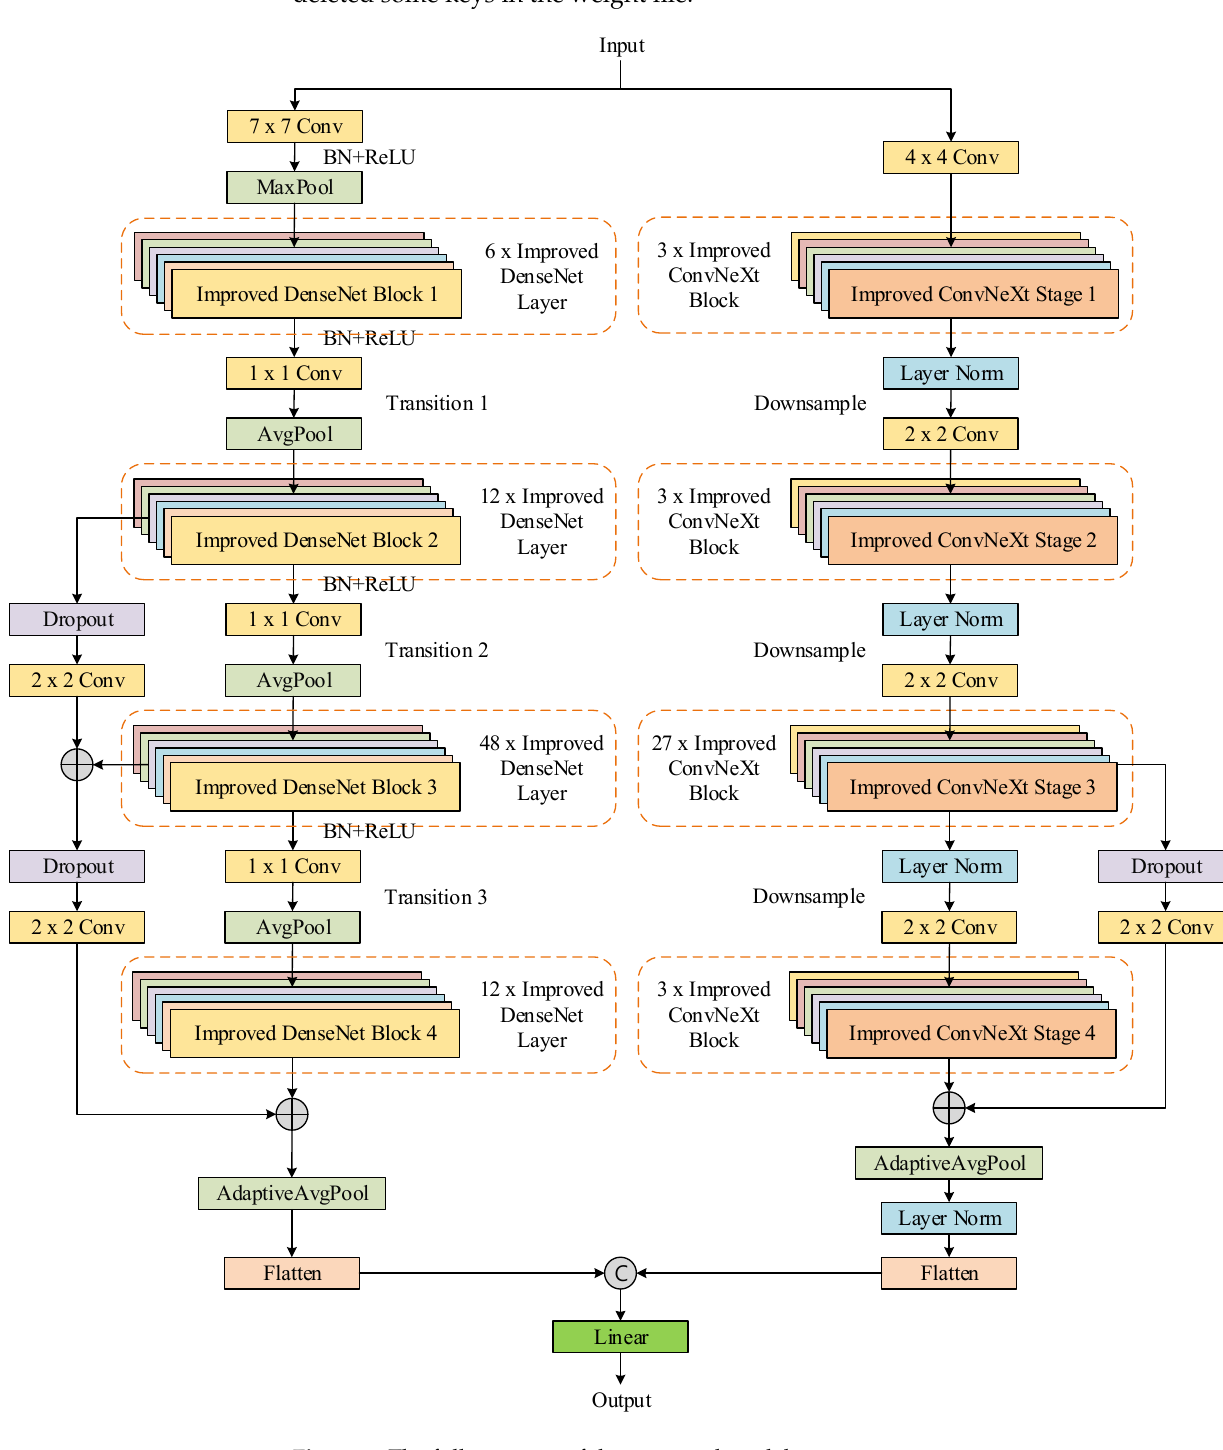
Figure 3. The full structure of the proposed model.